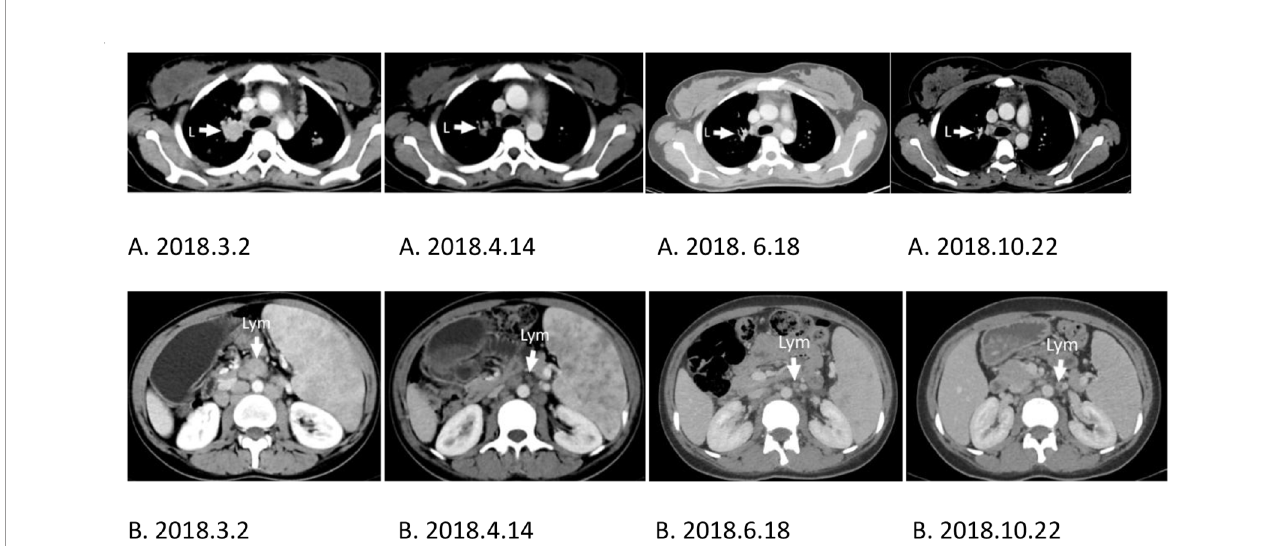
FIGURE 4 | L, Lung; Lym, lymphonodus. (A, B) CT scans comparing the same location as indicated by the arrow at different times showing tumor reduction. (A) Lung metastasis. (B) Lymphadenopathy of the abdomen. (A, B) 2018.3.2. The baseline of lung metastasis or lymphadenopathy of the abdomen before CD19 CAR T-cell treatment. (A, B) 2018.6.18. The baseline of lung metastasis or lymphadenopathy of the abdomen before CD30 CAR T-cell treatment.